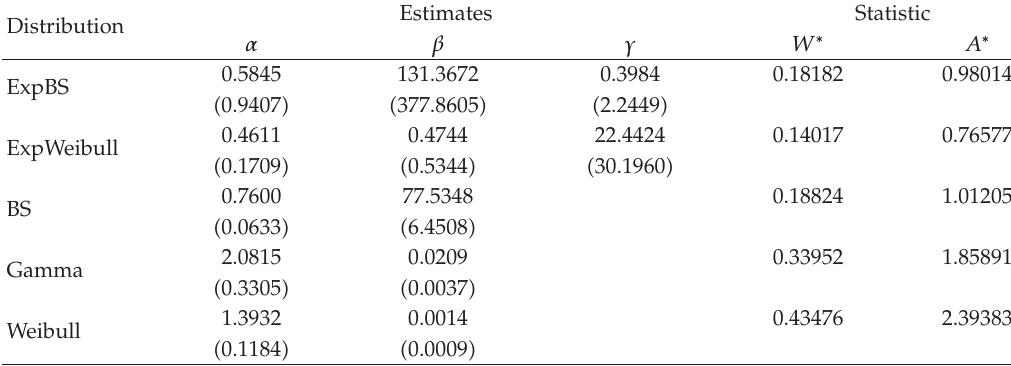
Table 3: MLEs (cid:2) standard errors in parentheses (cid:5) and the measures W ∗ and A ∗